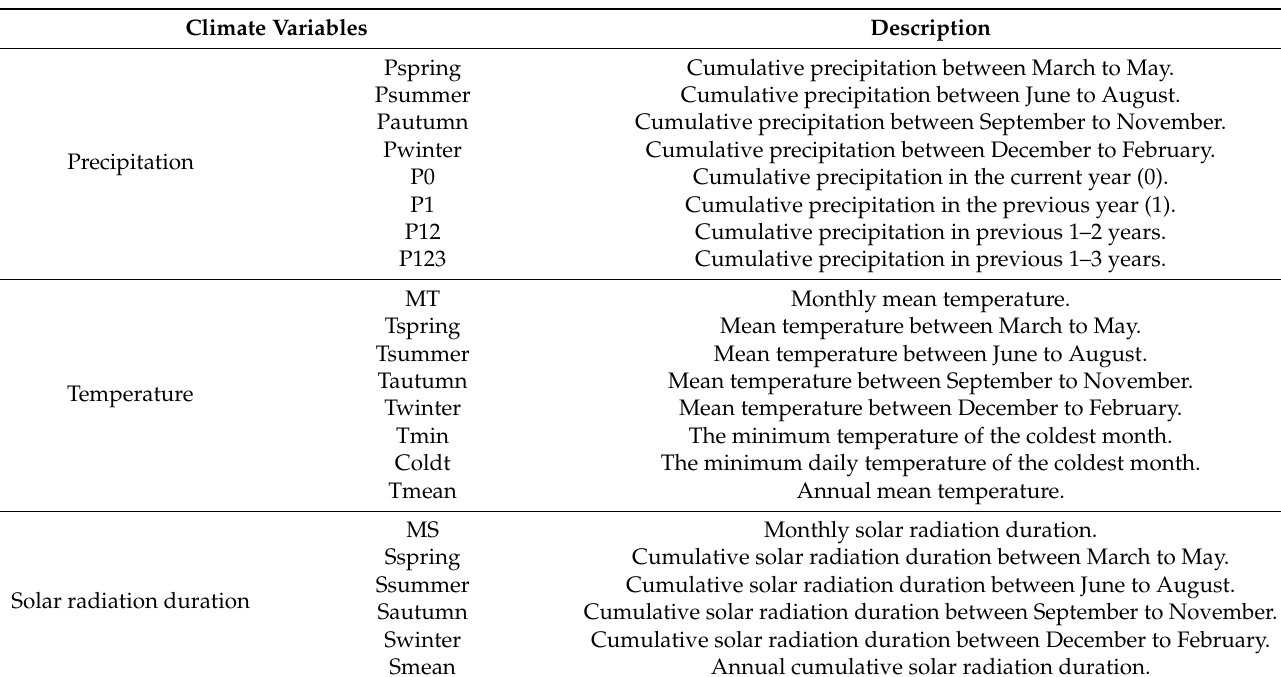
Table 2. Description of the explanatory variables used in the PLS model of the probability of pine shoot beetle infestation of forests in Southwest China from 2000 to